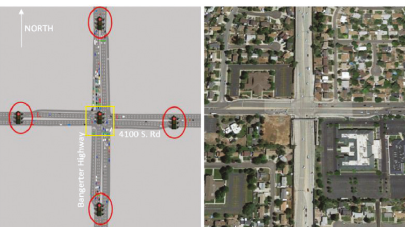
Figure 3: The coded model and screenshot for the CFI location obtained from VISSIM 8.0 and Google